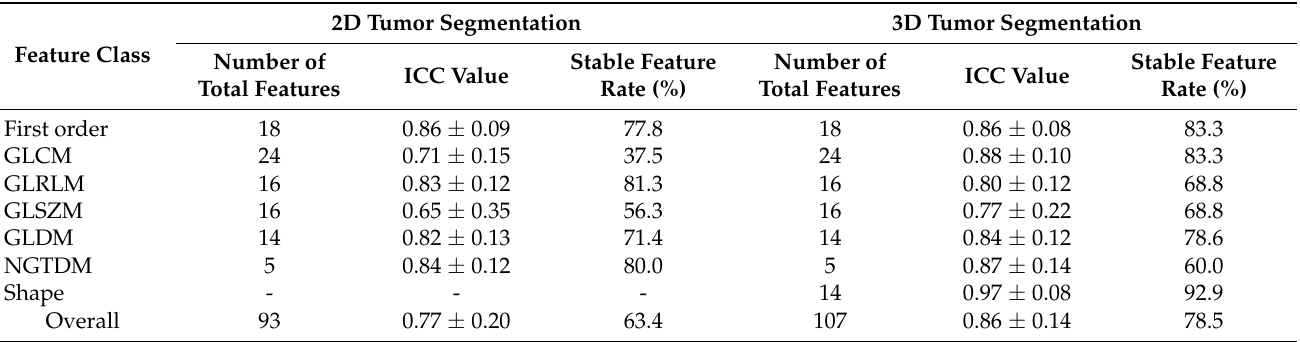
Table 2. Intra-observer variability of the radiomic-features family and stable feature rate for 2D and 3D tumor